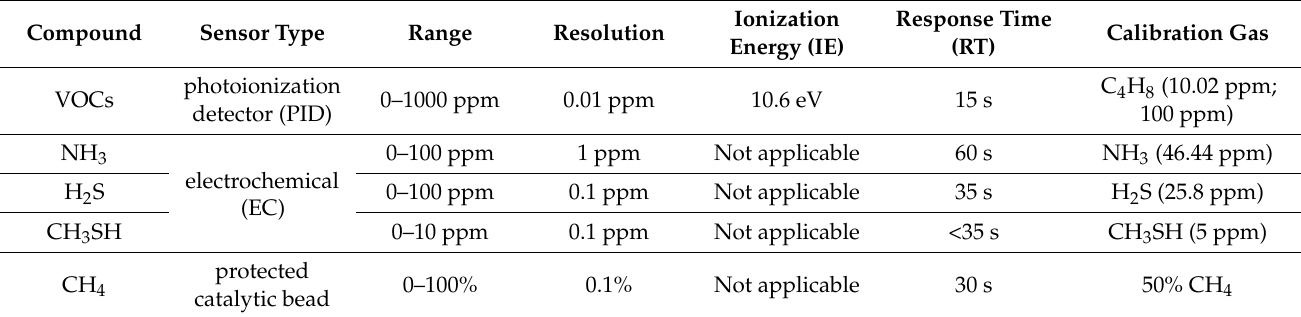
Table 1. Portable gas detector chemical sensors characteristic [20,51].